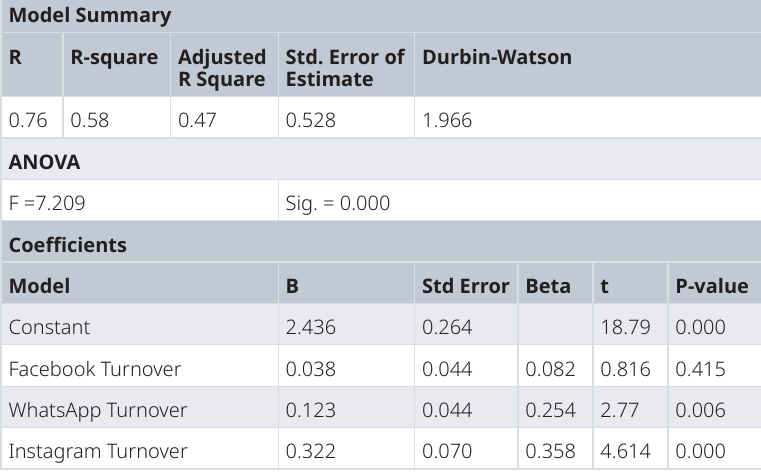
Table 6. Usage of social media and turnover of agricultural products. Model